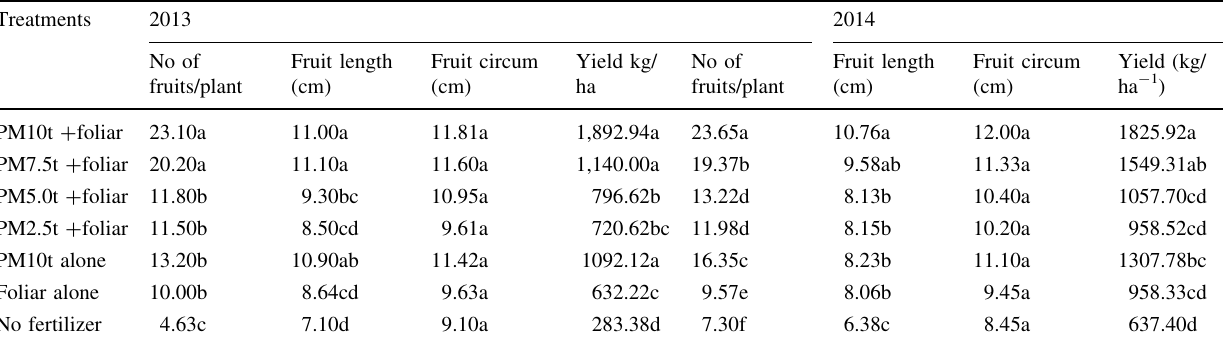
Table 4 Effects of combined application of poultry manure and foliar fertilizer (boost Xtra) on yield and yield components of okra in 2013 and 2014 cropping seasons